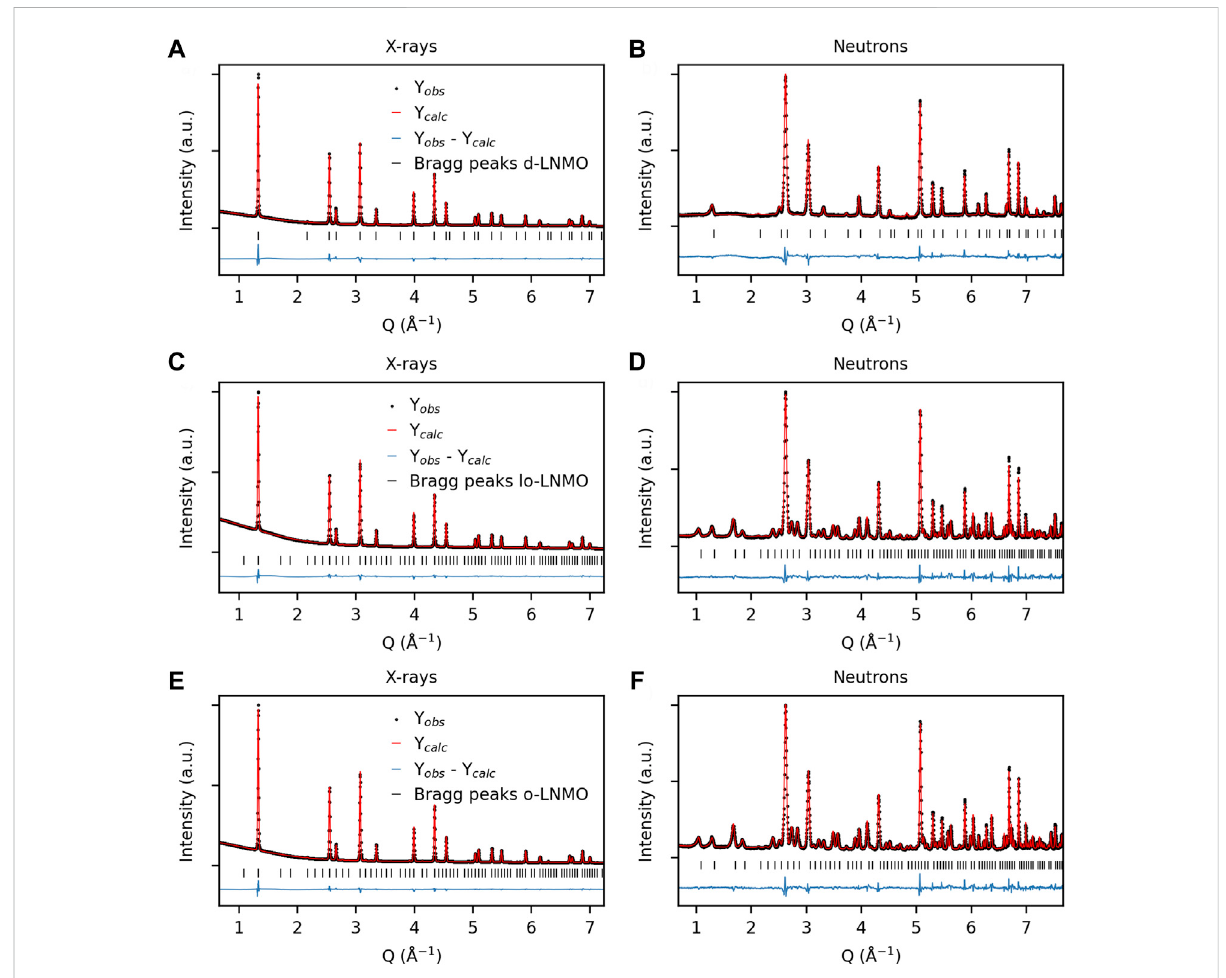
FIGURE 1 Observed and calculated diffraction patterns from combined Rietveld re fi nement of X-ray and neutron diffraction data for (A – B) disordered LiNi 0.44 Mn 1.56 O 4 (d-LNMO), space group Fd 3 m , (C – D) less ordered LiNi 0.44 Mn 1.56 O 4 (lo-LNMO), space group P 4 3 32 and (E – F) ordered